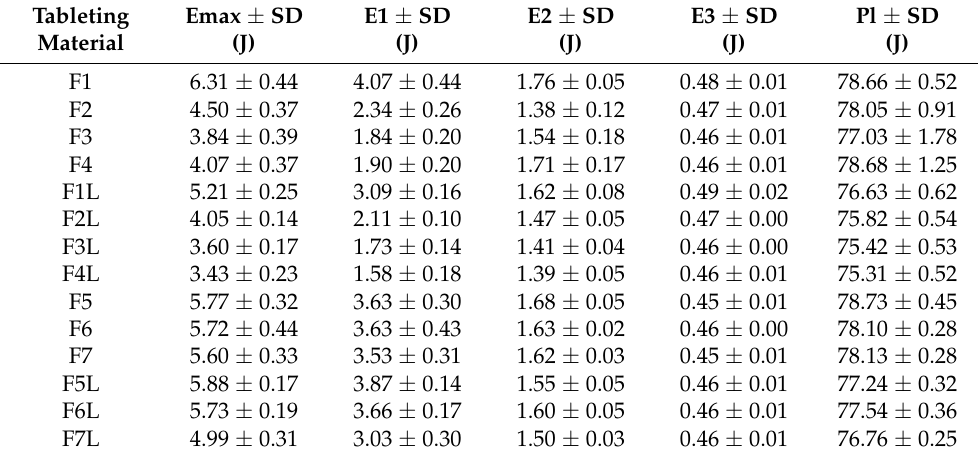
Table 3. Values of energy profile of compression and plasticity—tableting materials with chitosan.